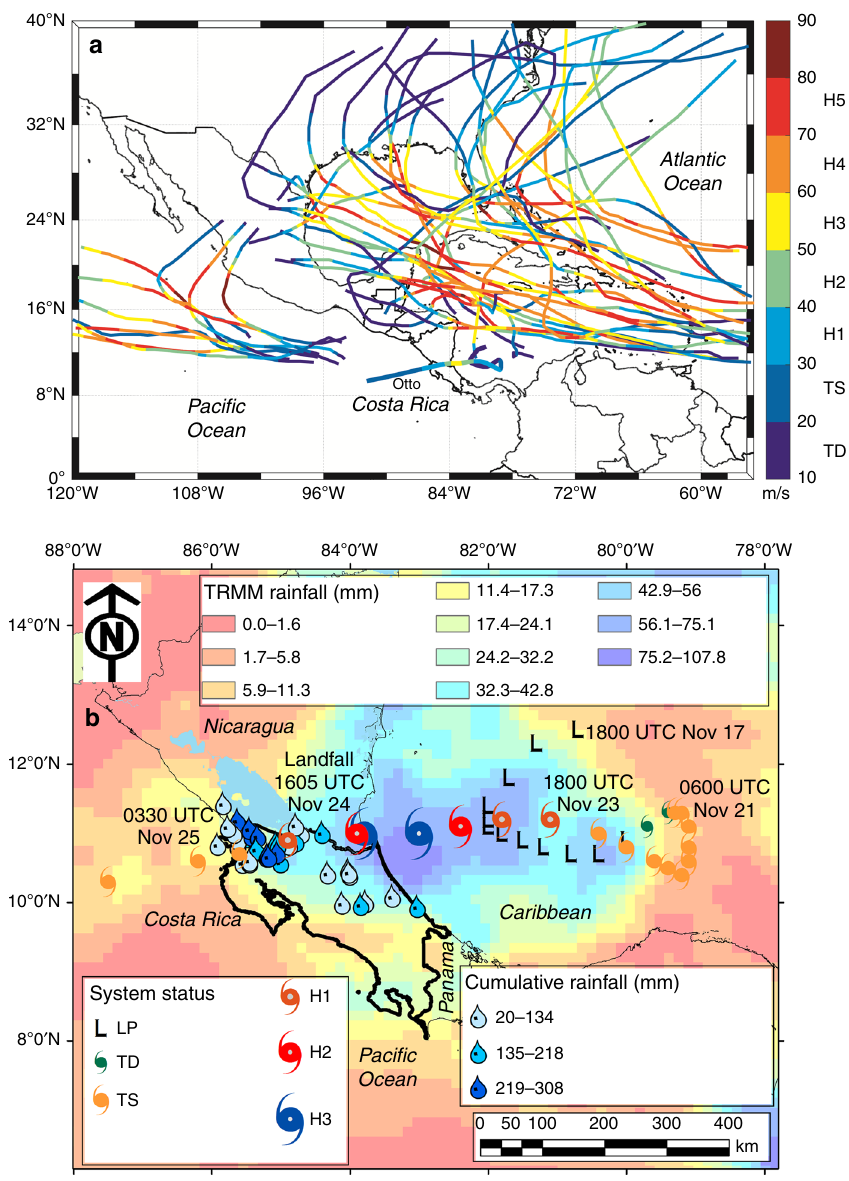
Fig. 1 Historical, major hurricane tracks comparison and Hurricane Otto main characteristics. a Historical, category 5 hurricane tracks with at least one segment along trajectory as category 3 for the Atlantic and eastern Tropical Paci fi c basins (1900 – 2017), bolder trajectory line denotes the best track of Hurricane Otto (November 20 – 26, 2016). Historical trajectories were constructed based on a combined dataset of NHC (National Hurricane Center) archive and HURDAT (Hurricane Databases) (https://www.aoml.noaa.gov/hrd/hurdat/Data_Storm.html). Wind speed (m/s) segments are color-coded with their respective storm category. b System status from 1800 UTC (Universal Time Coordinated) November 18 to 1200 UTC November 25, 2016. Raindrops represent ground-based cumulative rainfall during November 24 – 25, 2016. Raster color-coded grid shows cumulative rainfall estimated for November 23 – 25, 2016 from TRMM (Tropical Rainfall Measuring Mission)